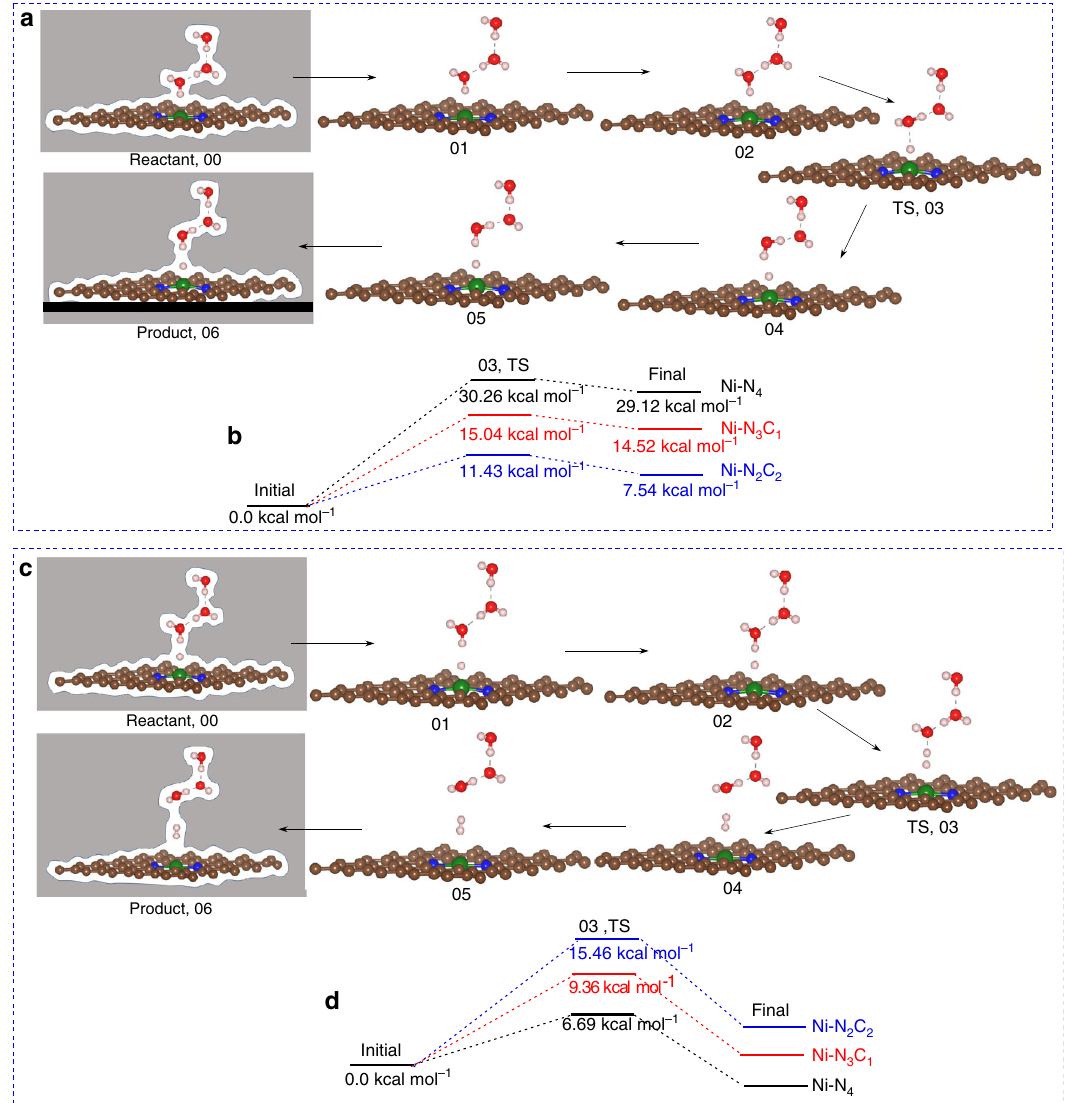
Fig. 6 Reaction pathways for hydrogen evolution reaction (HER) on nickel single site. a The minimum energy reaction path for proton adsorption (Volmer step) from solution to the nickel single site at − 0.8 V applied potential. We use total seven images (00 – 06) for this adsorption step. The hydrogen near the single nickel at point 00 gradually moves toward the nickel site leading to a transition state (TS) at 03 before converting into the adsorbed fi nal state at 06. b The adsorption free energies and TS barrier for the Volmer step of HER on different nickel sites at − 0.8 V vs RHE applied potential. Among all sites, Ni – C 2 N 2 shows a lower activation barrier for proton transfer at the active site. c The Heyrovsky reaction path for hydrogen gas evolution from the nickel surface at − 0.8 V applied potential. We use seven images (00 – 06) to describe the H 2 desorption step. The adsorbed hydrogen at point 00 reacts with a proton from solution to form H 2 gas at 06, leading to a transition state at point 03. d Desorption reaction barrier for the Heyrovsky step of HER on different nickel sites at − 0.8 V vs RHE applied potential. The H 2 evolution is dif fi cult from Ni – C 2 N 2 site because its strong adsorption energy for the Volmer step. The arrow indicates the forward reaction pathways for adsorption and desorption steps, respectively. (Gray color: entire surface represents implicit solvation along the whole reaction pathways, brown: carbon, blue: nitrogen, green: nickel, red: oxygen, off white: hydrogen